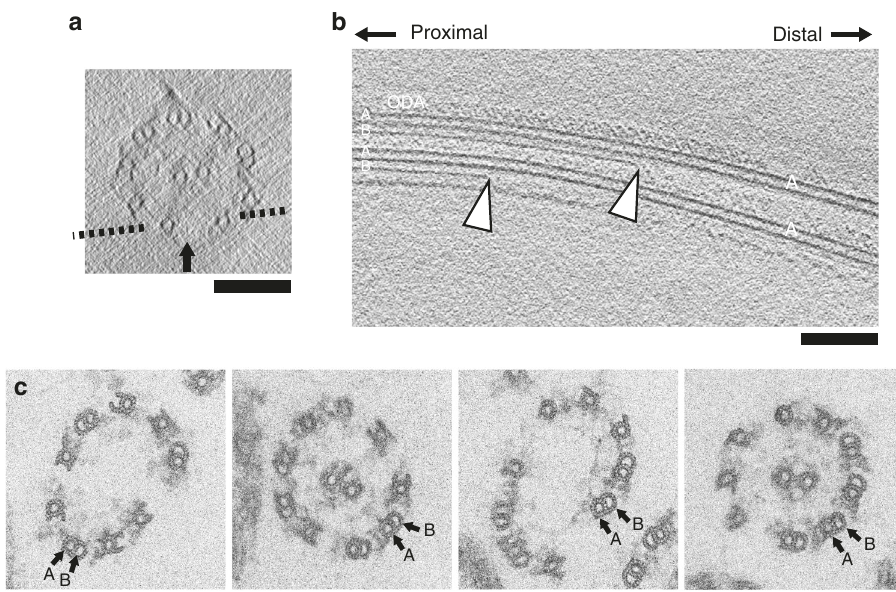
Fig. 4 B-tubules are partially depolymerized in fap45fap52 . a , b A typical tomogram of a fap45fap52 axoneme in cross-sectional ( a ) and longitudinal view ( b ). A dashed line in ( a ) indicates the slicing plane of ( b ). Arrowheads in ( b ) show break points in the B-tubules. c Typical thin section TEM images of fap45fap52 axonemes. Broken B-tubules were observed in 33.8% of the DMTs ( n = 552). The 9 + 2 structure was disorganized and the axonemes were frayed in regions containing broken B-tubules. Scale bar = 100